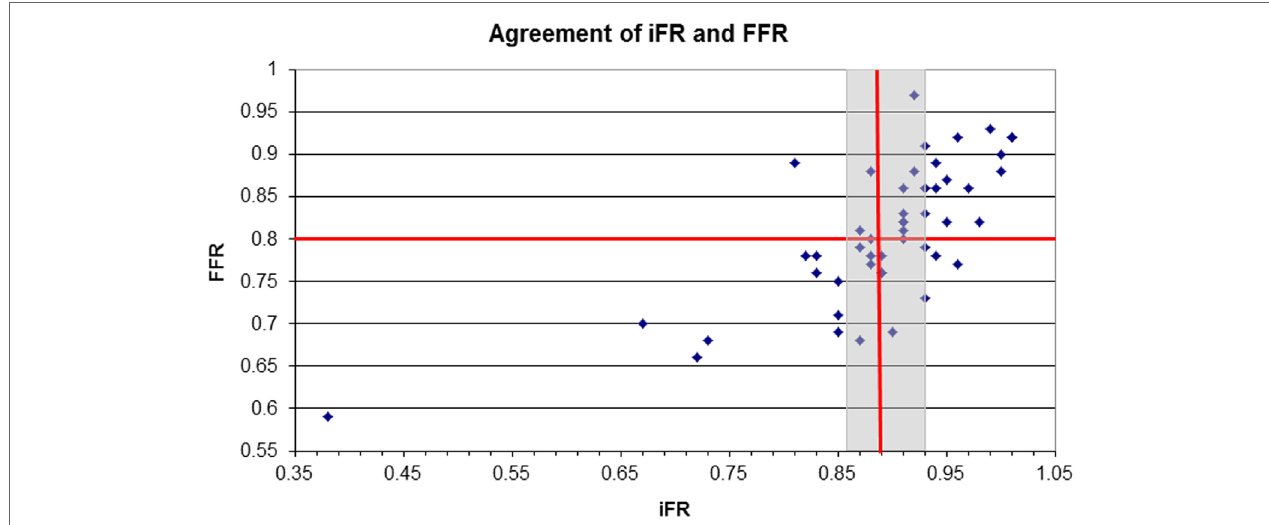
FigUre 1 | scatter plot of instantaneous wave-free ratio (iFr) and fractional flow reserve (FFr) measurements for individual lesions . The treatment cut-off points of iFR ≤ 0.89 and FFR ≤ 0.8 are marked with red lines. The gray zone for iFR of 0.86–0.89 is shown by the gray